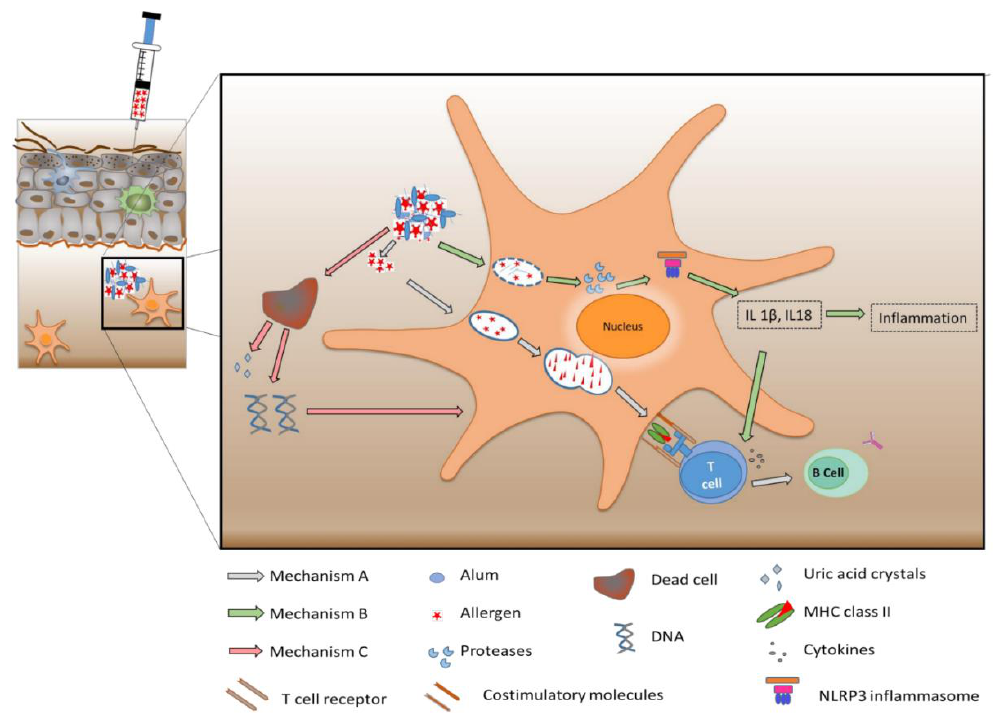
Figure 2. Scheme of three mechanisms of alum’s action as adjuvant for allergen-specific immunotherapy (AIT). Mechanism A—depot formation leading to immunomodulation; Mechanism B—NLRP3 inflammasome activation resulting in allergen-specific antibody production; and Mechanism C—induction of self-DNA release promoting dendritic cell